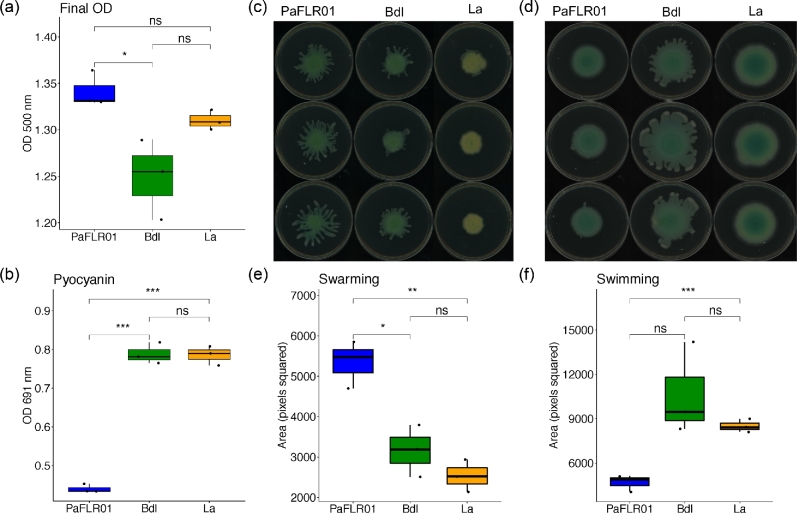
Phenotypic response of PaFLR01 to fermentation products. (a) Final optical density (OD) at 500 nm and (b) pyocyanin measurements at 691 nm were taken after 48 h of incubation at 37°C. Phenotypic (c) swarming and (d) swimming assays were set at 48 h at 37°C. Area quantification of (e) swarming and (f) swimming colonies was performed with ImageJ. Dots within each boxplot indicate each biological replicate. Bdl = PaFLR01 + 20 mM 2,3-butanediol. La = PaFLR01 + 20 mM lactic acid. Pairwise T tests were performed to determine significance. *p value < 0.05; **p value < 0.01; ***p value < 0.001; ns = p value > 0.05, not significant.